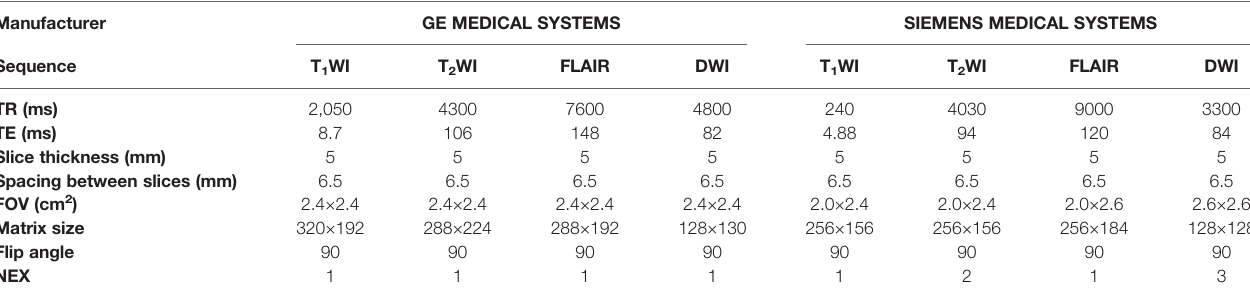
TABLE 2 | Parameters setting of the MRI scanning in our hospital.